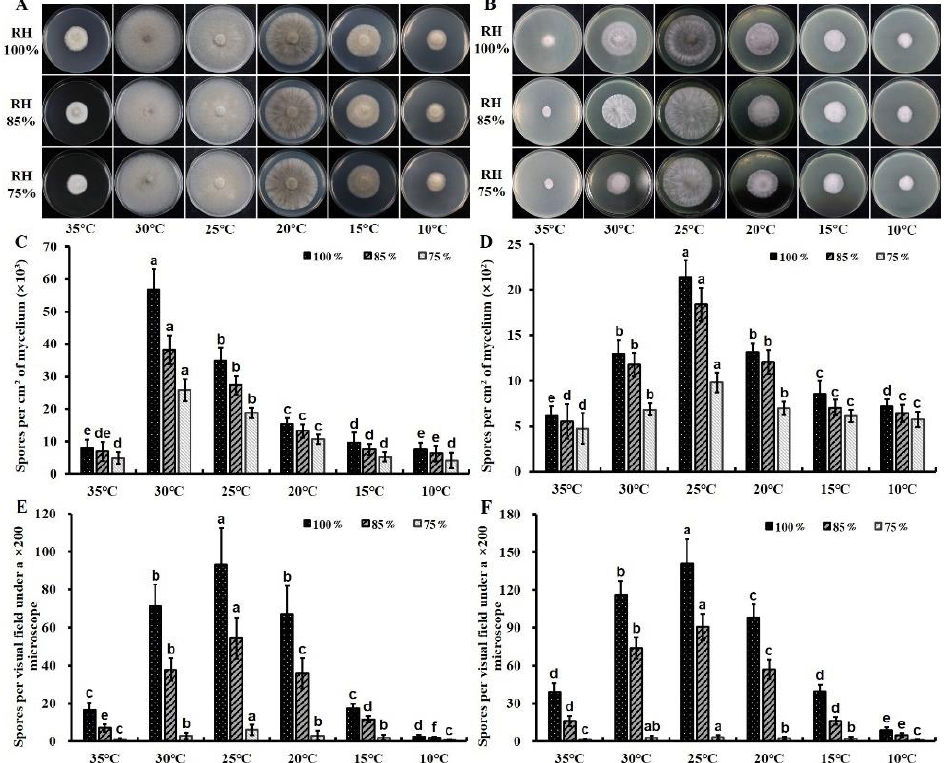
Figure 2. Colony morphology and sporulation production of Corynespora cassiicola on different substrates at six temperatures (10, 15, 20, 25, 30, and 35 ◦ C) with three moisture levels (75%, 85%, and 100% RH) per temperature. ( A , B ) Colonies of C . cassiicola on potato dextrose agar (PDA) and cucumber − leaf extract agar (CEA) at 12 days after incubation (DAI). ( C , D ) Sporulation production of C . cassiicola on PDA and CEA at 12 DAI. Spore production number was reported as spores per sq cm of mycelium. ( E , F ) Sporulation production of C . cassiicola on detached and living leaves of cucumber at 12 h after incubation. Spore production number was reported as spores per visual field under a × 200 microscope. Data are means of three experimental repetitions. Different letters represent significant ( p < 0.05) differences with post hoc multiple comparisons according to Tukey’s